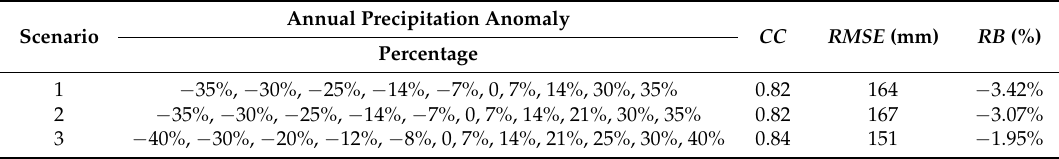
Table 2. Three test scenarios with different annual precipitation anomaly